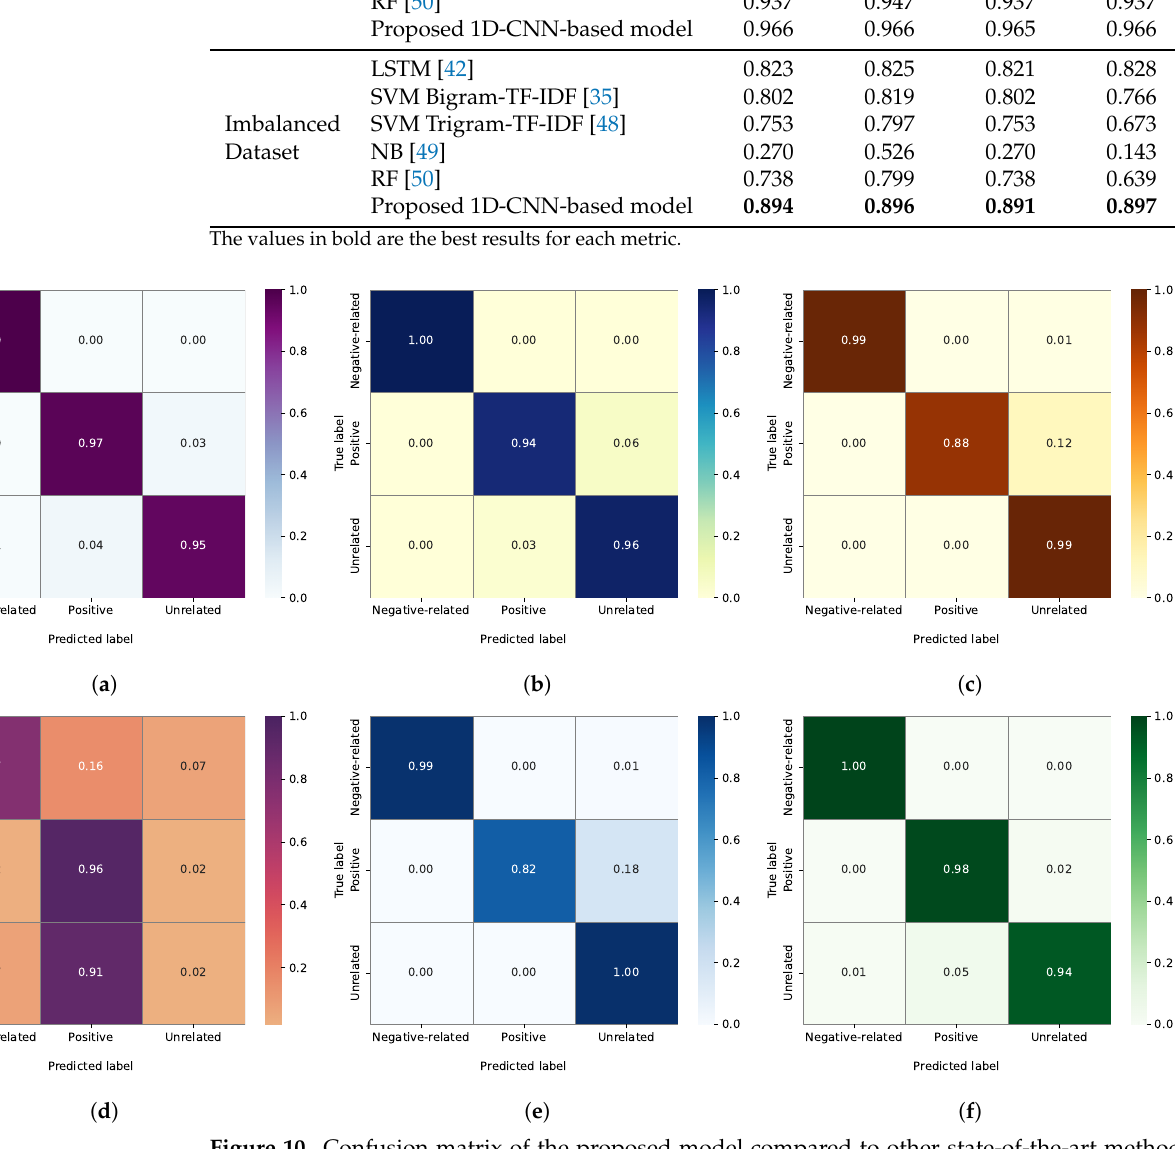
Figure 10. Confusion matrix of the proposed model compared to other state-of-the-art methods on oversampled data. ( a ) LSTM [42]. ( b ) SVM Bigram-TF-IDF [35]. ( c ) SVM Trigram-TF-IDF [48]. ( d ) NB[49]. ( e ) RF [50]. ( f ) Proposed 1D-CNN-based